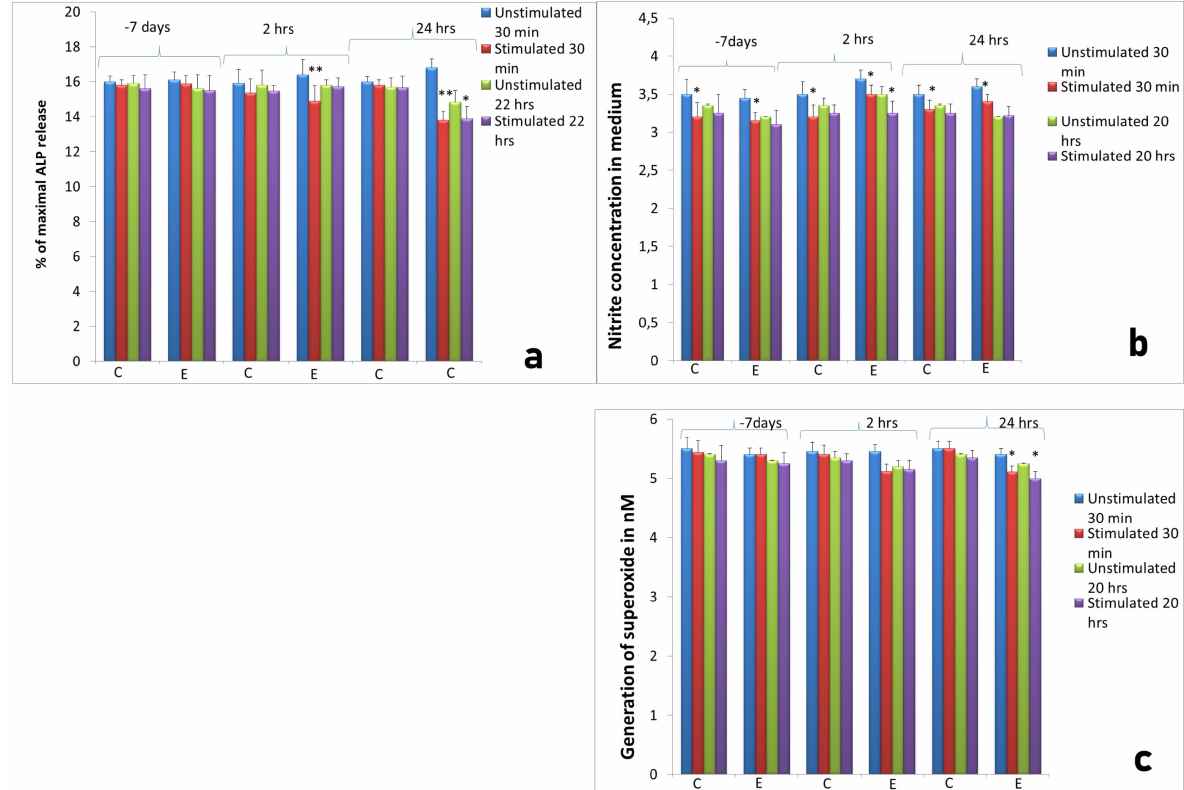
Figure 1. Activity of neutrophils isolated 7 days before, 2 h and 24 h after implantation (experimental: 8 sheep) compared to control groups of neutrophils isolated at the same time points from animals from control groups (control: 4 sheep). C: control group, E: experimental group. The neutrophil response to Ti implant insertion, with or without stimulation with AMP extract; ( a ) ALP release from neutrophils, ( b ) NO generation release, ( c ) superoxide generation in the inflammatory phase of the repair process assessed at two measurements, after 30 min and 22 h incubation at 37 ◦ C and 5% CO 2 . Data present mean values ± SE of at least three replicates for each bar. * p < 0.05 compared to cultures of neutrophils from the control group at the same time points. ** p <